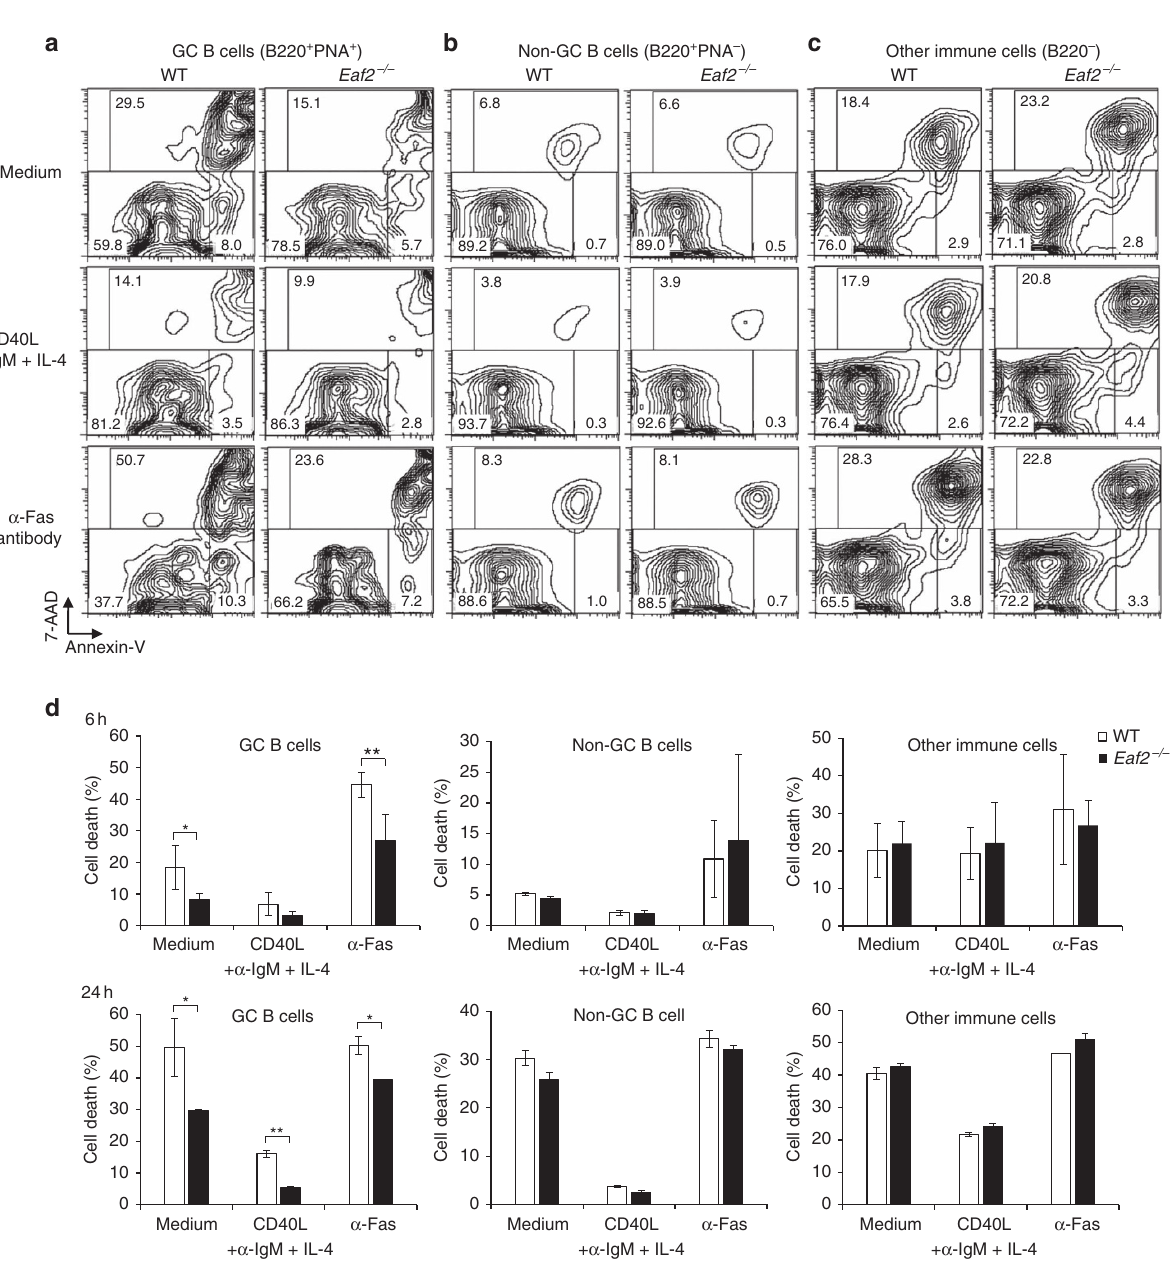
Figure 2 | GC B cells from Eaf2 (cid:3) / (cid:3) mice show decreased cell death compared with WT GC B cells. Cells from Peyer’s patches (10 6 cells per ml) were cultured in medium alone or in the presence of CD40L þ a -IgM þ IL-4 or an agonistic anti-Fas Ab for 6h and then analysed for cell death as in Fig. 1 in gated GC B cells ( a ), non-GC B ( b ) and other immune cells ( c ). ( d ) Summary of the results obtained with three pairs of WT and Eaf2 (cid:3) / (cid:3) mice. Upper panels, 6h culture; Lower panels, 24h culture. White bars, WT; Solid bars, Eaf2 (cid:3) / (cid:3) . * P o 0.05; ** P o 0.01 (paired t -test). NATURE COMMUNICATIONS|7:10836|DOI: